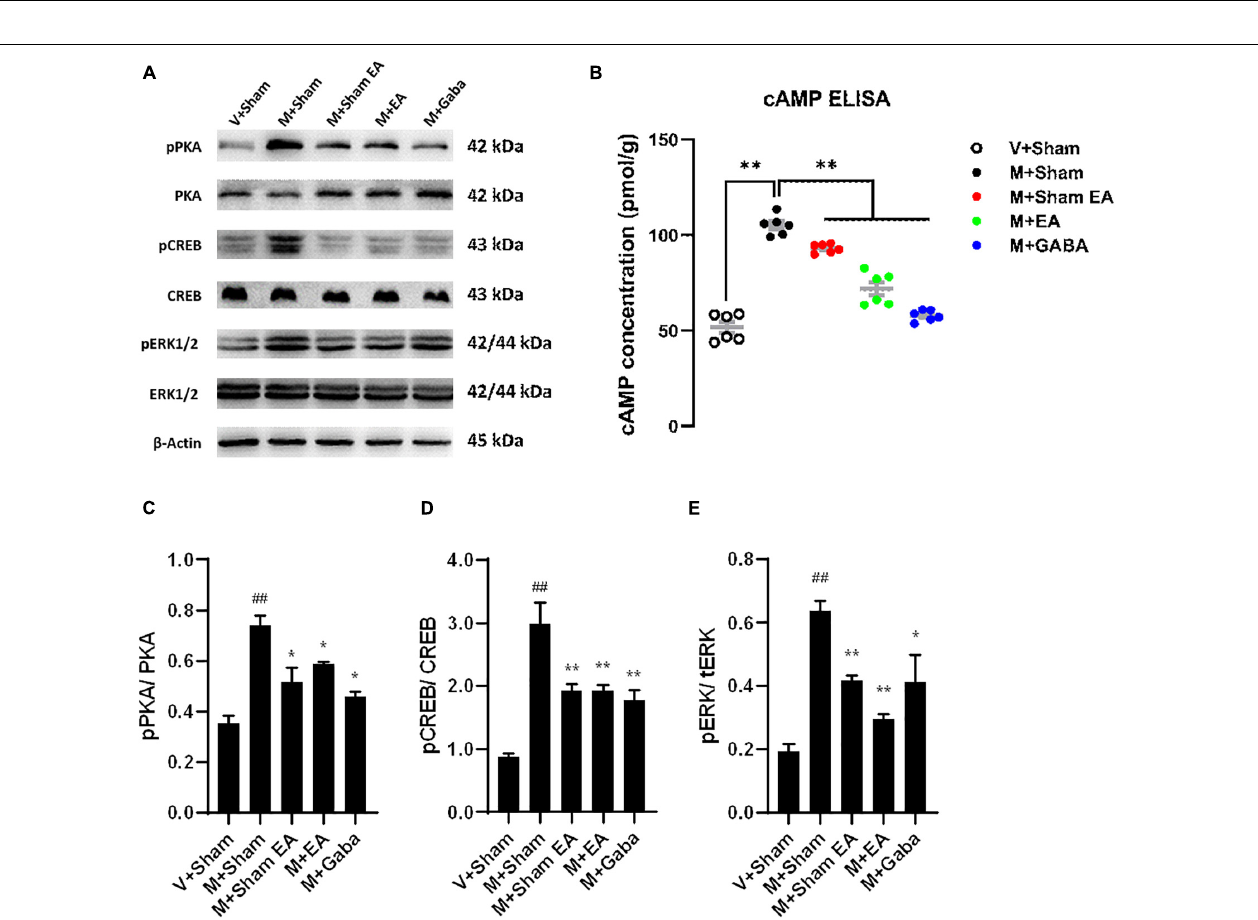
FIGURE 6 | Effects of EA treatments on the protein expression in brainstem. (A) The brainstem tissues were lysed and analyzed by Western blotting using antibodies against PKA, phospho-PKA, ERK1/2, phospho-ERK1/2, CREB, and phospho-CREB. Representative blot was shown. GAPDH serves as loading control. (B) Effects of EA treatments on adenylyl cyclase activity (cAMP) after chronic morphine treatment. cAMP activity was assessed in BS after 5 days of chronic morphine treatment (10 mg/kg, s.c., per day). Data represent the mean ± SEM of experiments performed in six BS from six animals of each group assayed in triplicate in parallel experiments. (C–E) Graphic representation of relative expressions of pPKA/PKA, pCREB/CREB, pERK/tERK, respectively.Data are presented as the mean ± SEM ( n = 4). The data were analyzed with one-way ANOVA followed by Bonferroni post hoc tests. * p < 0.05, *** p < 0.01, vs. M + Sham; ## p < 0.01, vs. V + Sham.